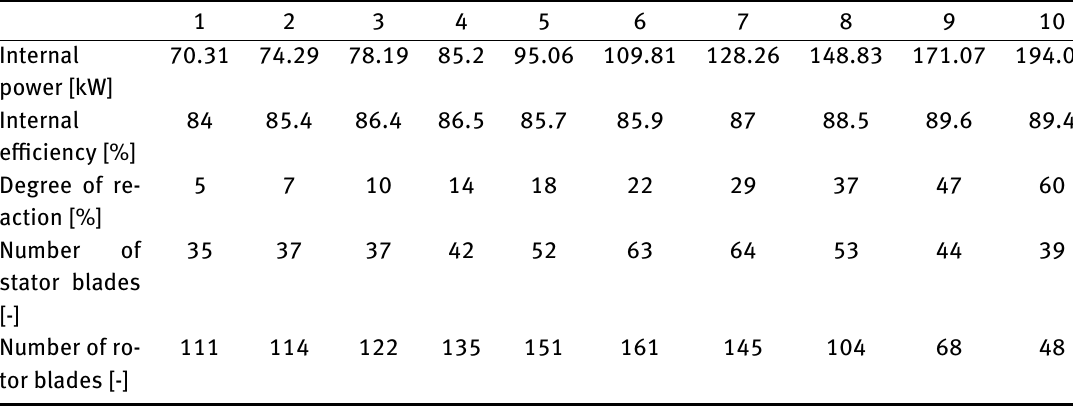
Table 9: Detailed results of 1D computations for 1 MW axial